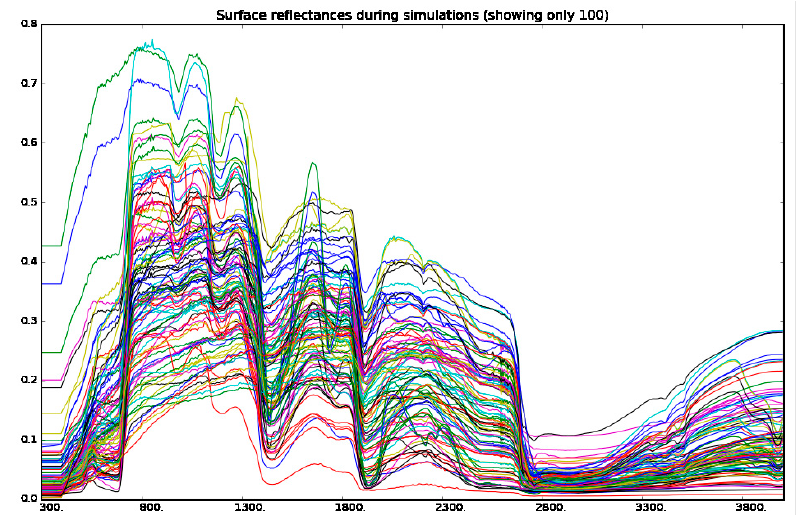
Figure A1. Simulated surface reflectance values for various soil types. Only 100 simulated surface reflectances are shown but, in practice, 50,000 were